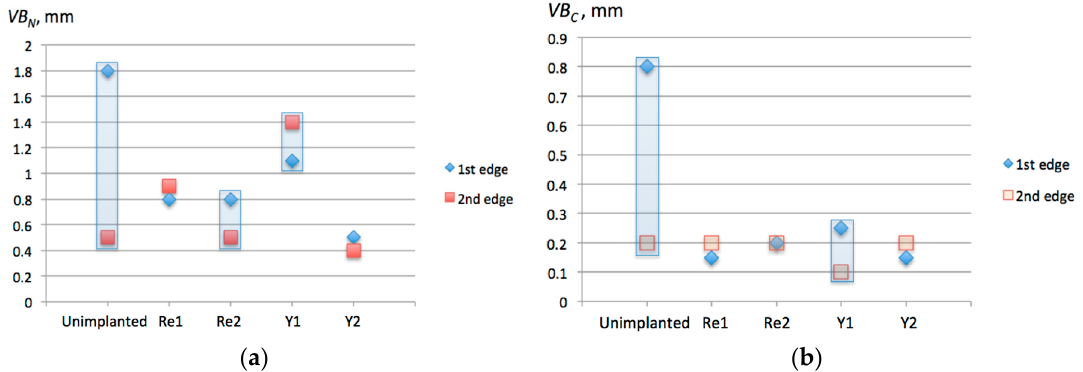
Figure 12. Wear parameters of TNGA 160408E (IS9) inserts measured on two edges each: ( a ) VB N ; ( b ) VB C . The respective symbols along X-axis denote: Unimplanted 1st and 2nd edge; Re1—Re + (1 × 10 17 ion / cm 2 ) implanted edges; Re2—Re + (2 × 10 17 ion / cm 2 ) implanted edges: Y1—Y + (1 × 10 17 ion / cm 2 ) implanted edges; Y2—Y + (2 × 10 17 ion/cm 2 ) implanted edges.